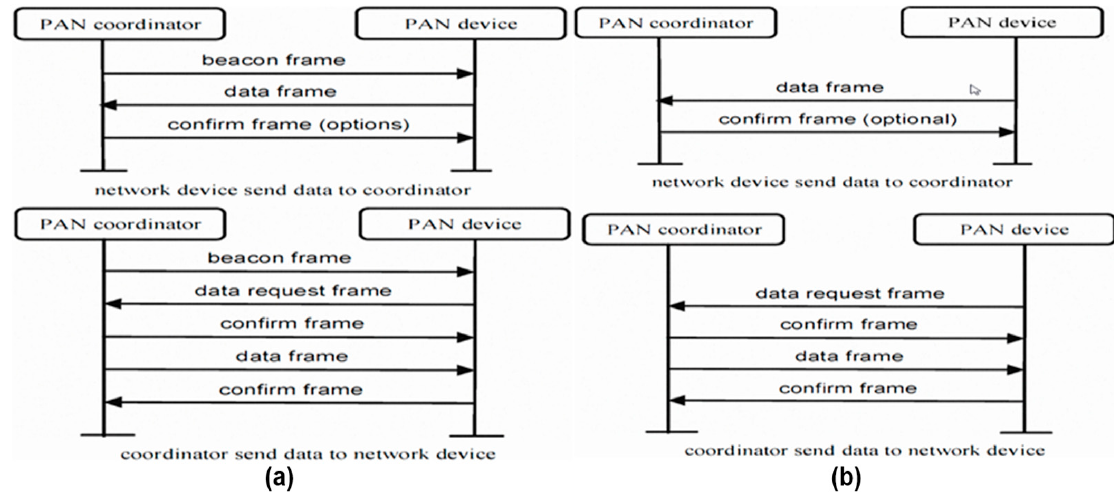
Figure 7. ( a ) Beacon-enabled in ZigBee ( b ) Non-Beacon-enabled in ZigBee.